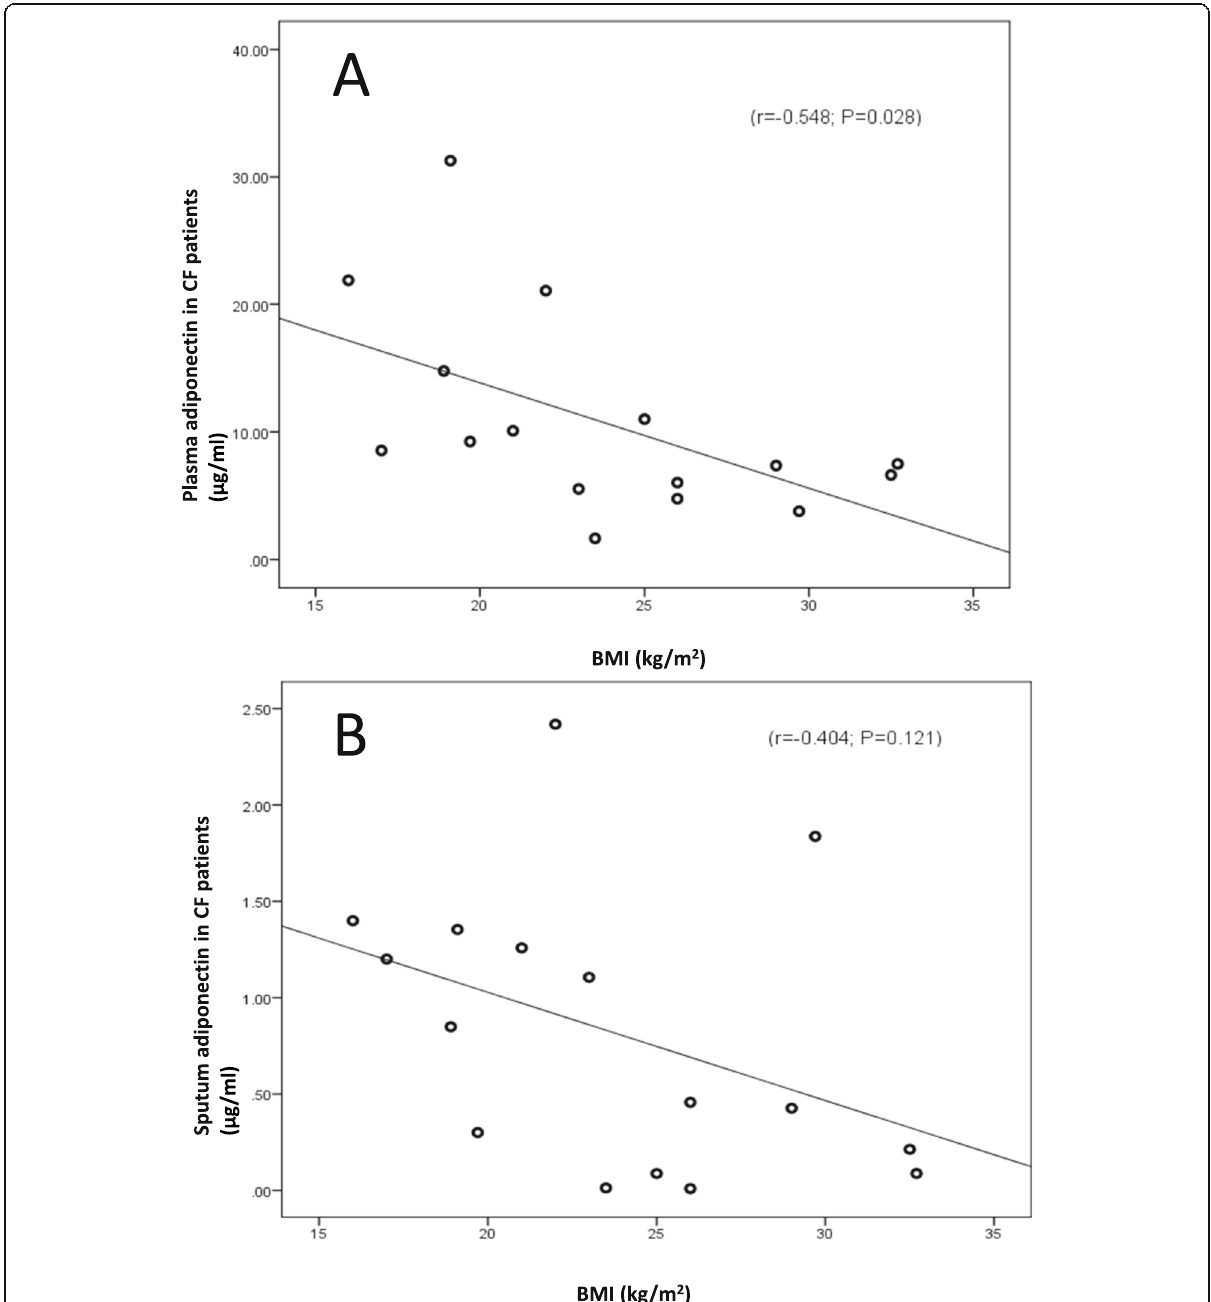
Fig. 3 a : Correlation between plasma adiponectin level in CF patients and BMI. b : Correlation between sputum adiponectin level in CF patients and